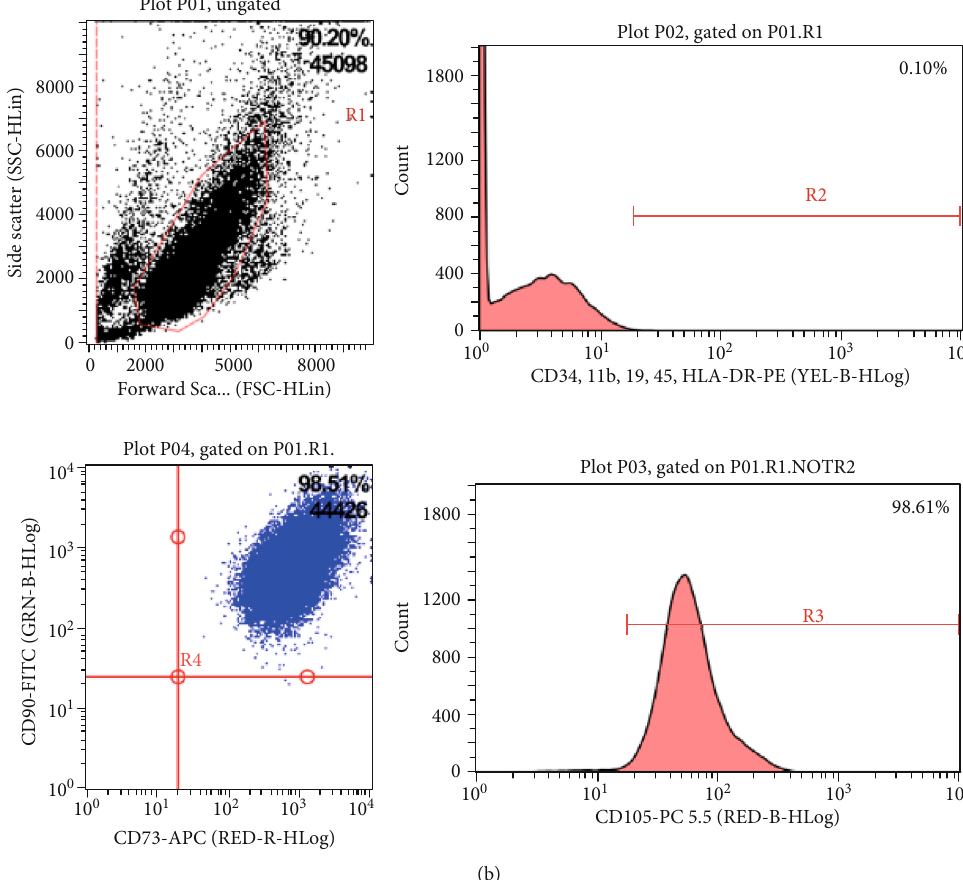
Figure 3: The surface markers of two types of MSCs characterized by fl ow cytometry: strong expression of CD105 and CD73 and no expression of CD34, CD11b, CD19, CD45, and HLA-DR. (a) BMSC; (b)